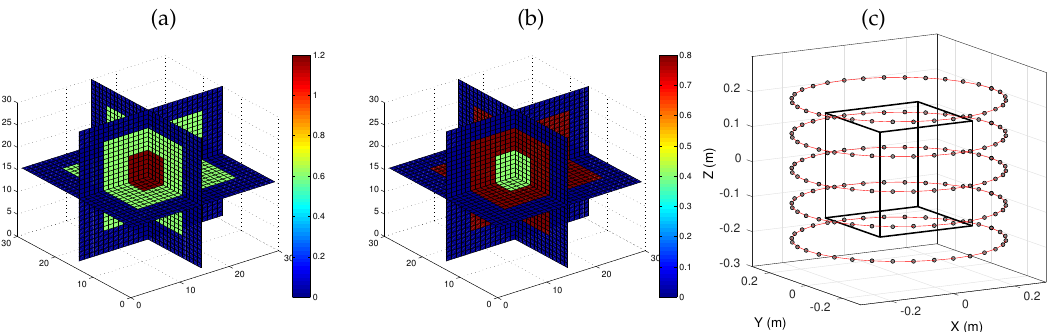
Figure 1. Real ( a ) and imaginary ( b ) parts of the contrast function of the simulated object (two nested cubes in air), with the corresponding discretization grids, and acquisition setup for the simulated object ( c ): the black cube represents the unknown volume V in which the object is placed. The gray circles represent the sources positions around the volume. The receivers are located at the same positions as the sources.